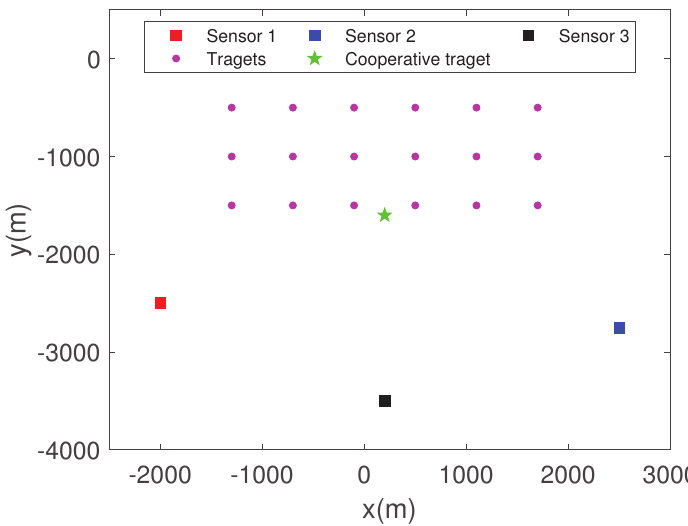
Figure 11. Scenario 2 with 18 stationary targets and 3 passive sensors. The positions of three passive sensors in the XY -plane are ( − 2000 m, − 2500 m), (2500 m, − 2750 m), and (200 m, − 3500 m), respectively. The standard deviations of the measurement errors for all sensors are σ s = 1 mrad, s ∈ { 1, 2, 3 } . The position of